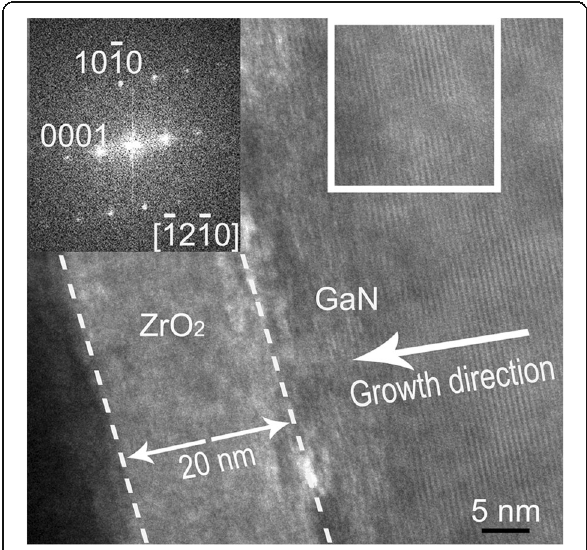
Fig. 2 Cross-sectional HRTEM image of MOS capacitors with O 3 as the oxidizer (the inset is the related FFT